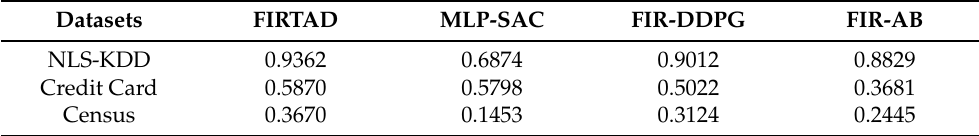
Table 3. AUC-PR Performance of FIRTAD and its Three Ablated